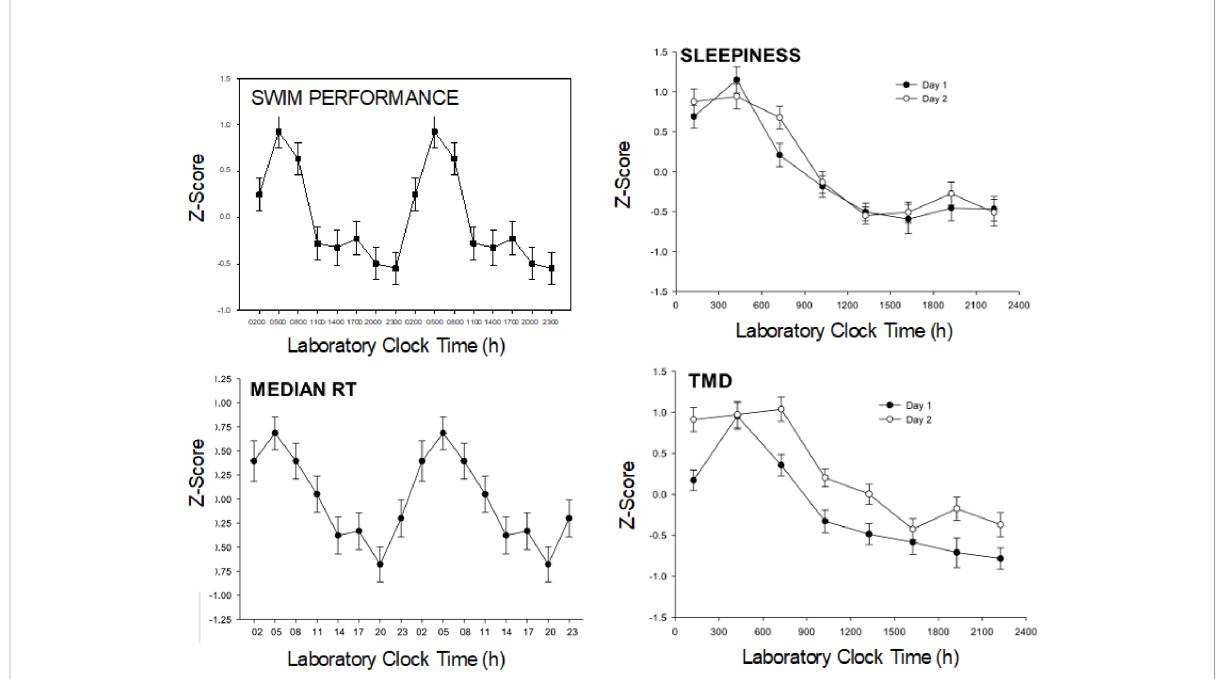
FIGURE 2 Example circadian rhythms. Data are from a study by Kline et al. N = 25 young adults followed an ultrashort sleep wake cycle (2 h wake: 1 h sleep) for 55 hours. Six 200 meter swim trials were performed at the indicated lab clock times throughout the day and night portions of the subject ’ s internal circadian rhythms (8 times/24 h). Similarly, the PVT (median reaction time RT), Pro fi le of Mood States (Total Mood Disturbance: TMD) and Stanford Sleepiness Scale were measured every wake period and the data were z-transformed (normalized). The swim performance and reaction time data are “ double-plotted ” after averaging over the 2 days to better show circadian patterns. Strong circadian rhythms were found in each of these variables with similar patterns observed on Day 1 and Day 2 (right two